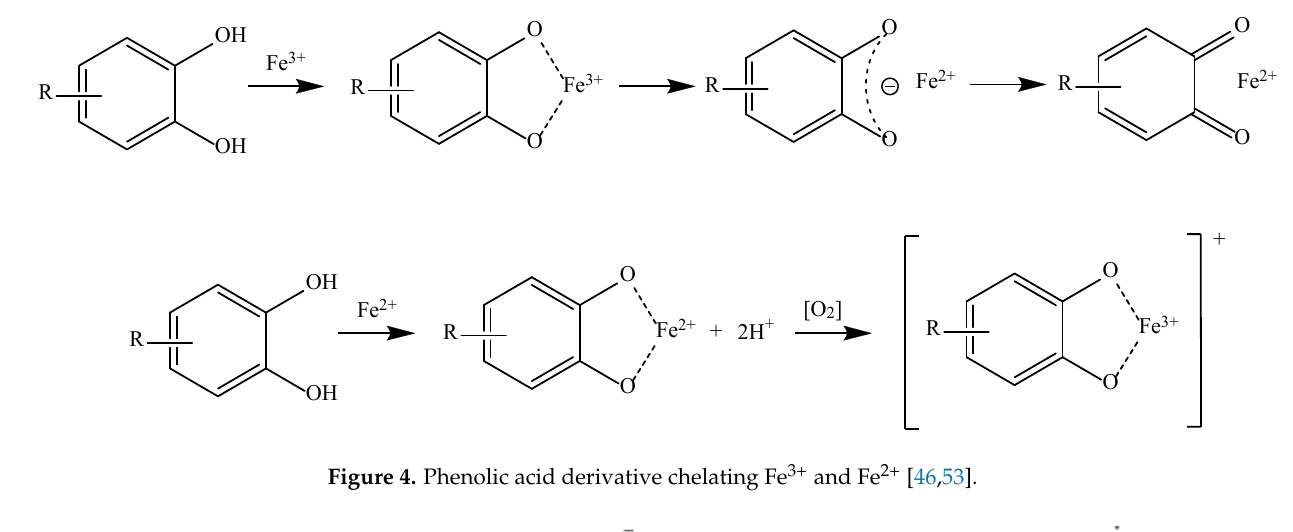
Figure 4. Phenolic acid derivative chelating Fe 3+ and Fe 2+ [46,53].